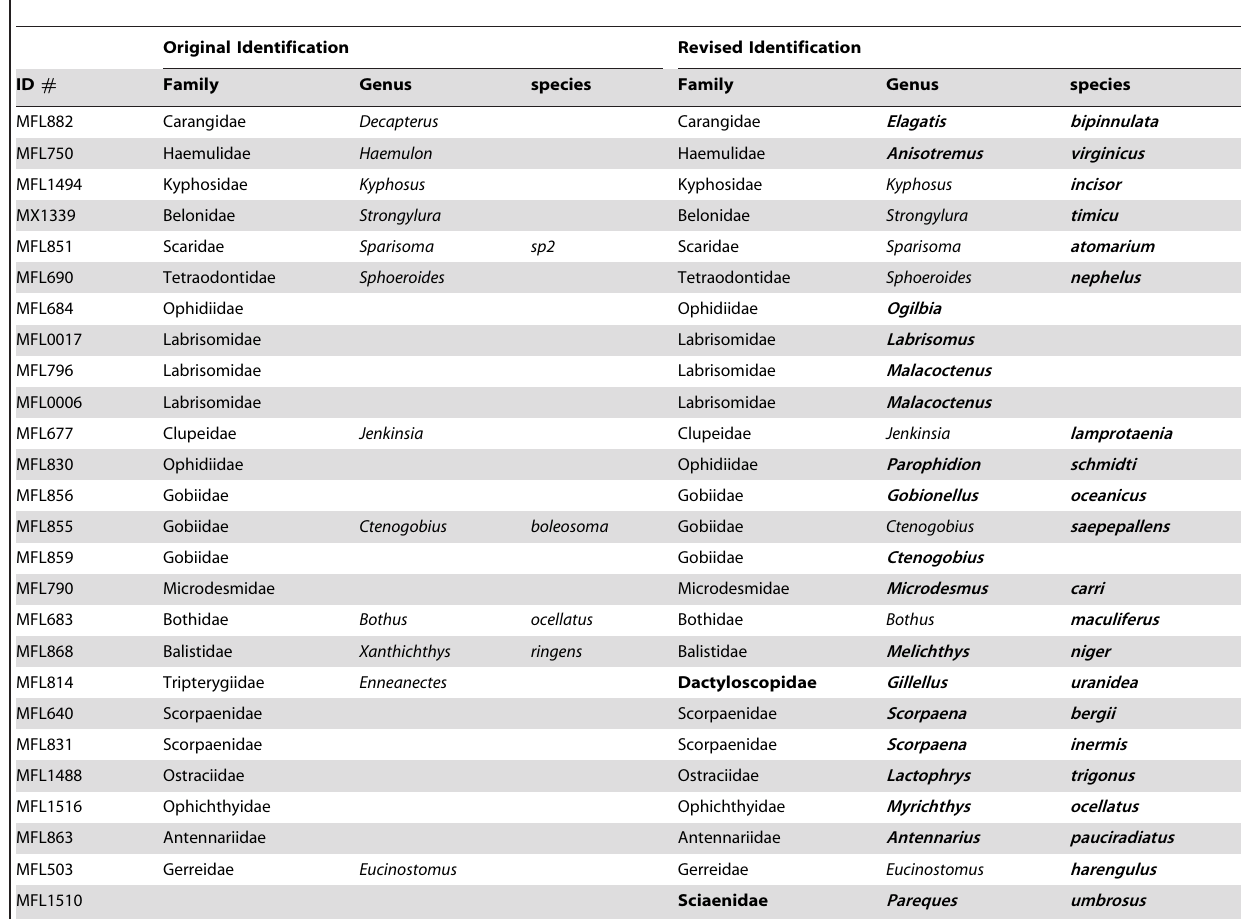
Table 3. Mexican larvae and juveniles with improved identifications (in boldface) due to increased taxon and geographic sampling. Original data from Valdez-Moreno et al